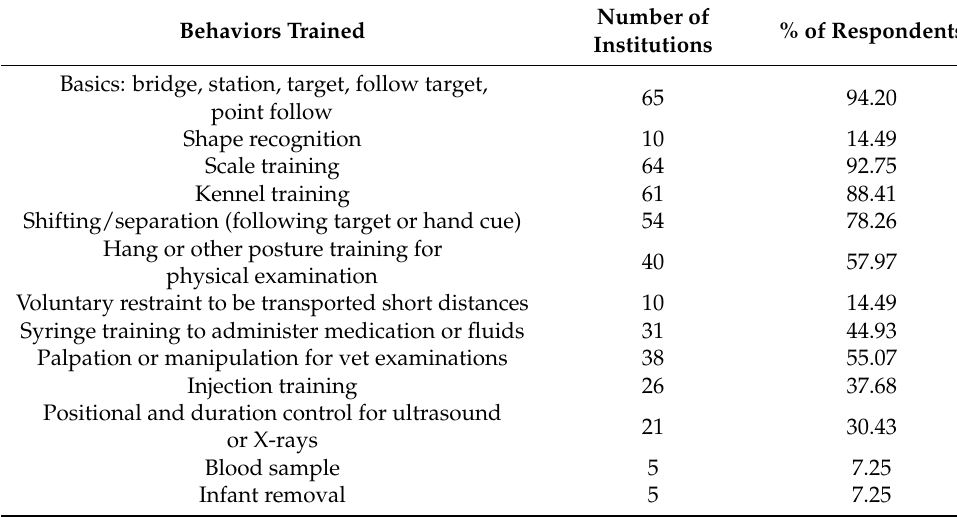
Table 4. Behaviors trained with strepsirrhine species in North American institutions ( n = 69). Behaviors Trained